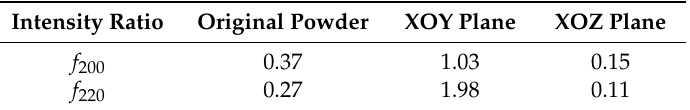
Table 2. Di ff raction peak intensity ratio. Table 2. Diffraction peak intensity ratio.